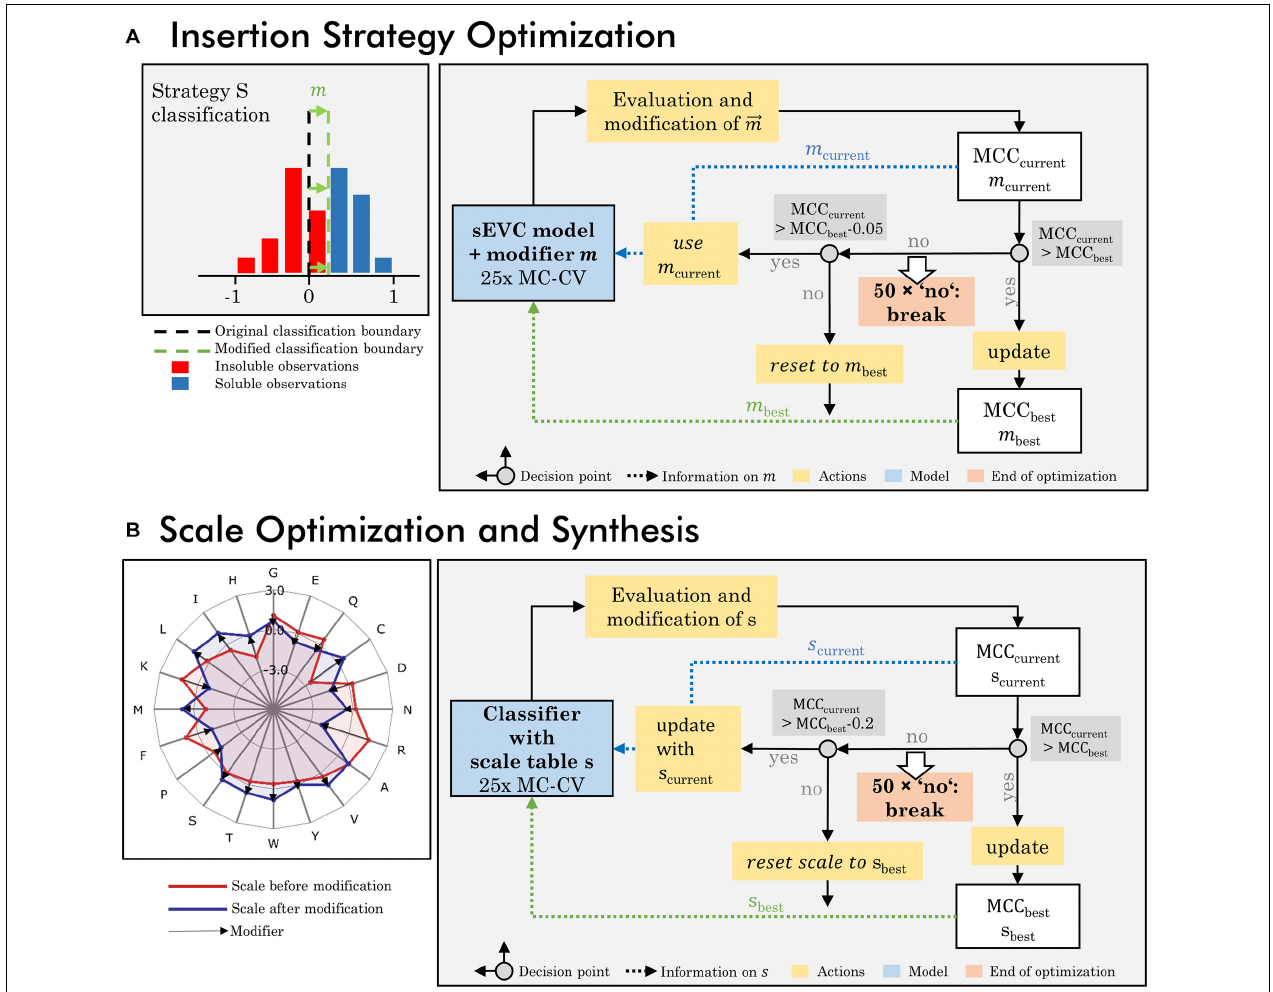
FIGURE 1 | Workflow of optimization procedures. (A) The insertion strategy optimization is based on modifying the classifier for a specific strategy to increase model performance. In a 25-fold Monte Carlo cross-validation (MC-CV), the previous modifier is evaluated and a new modifier is derived, based on systematic misclassification in the false-positive and negative group, specific for certain insertion strategies. This results in the current modifier m current and current MCC current . If MCC current is better than previous best MCC, the best MCC and modifier are updated and used for the next iteration. If the MCC current is lower than the best MCC within a defined acceptance margin of 0.05, the current modifier is used for the next iteration. If it is below this acceptance margin, the MCC and modifier are reset to the previous best MCC and modifier. If for 50 times, no improvement on the MCC has been made, the iteration is stopped. (B) Scale optimization and synthesis are based on an optimization of the individual amino acid’s hydrophobicity values in the hydrophobicity scale. In each iteration the previous scale is modified and probed in 25-fold MC-CV, resulting in a current MCC and scale s . The iteration rules are comparable to the insertion strategy optimization, with the difference that the acceptance margin is higher with 0.2 and the modified scales, as opposed to the modifiers in the insertion strategy optimization, are stored and